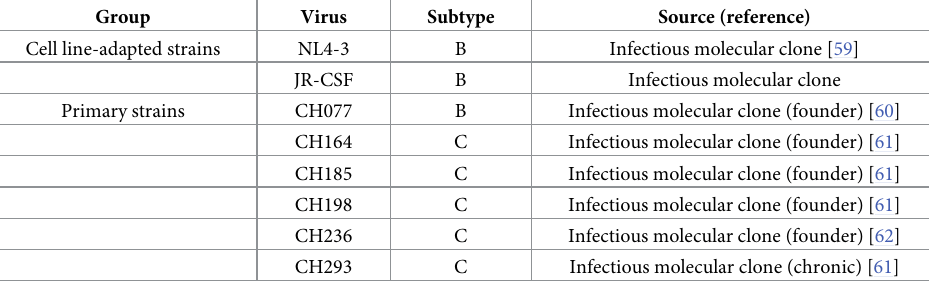
Table 1. HIV-1 strains used in this